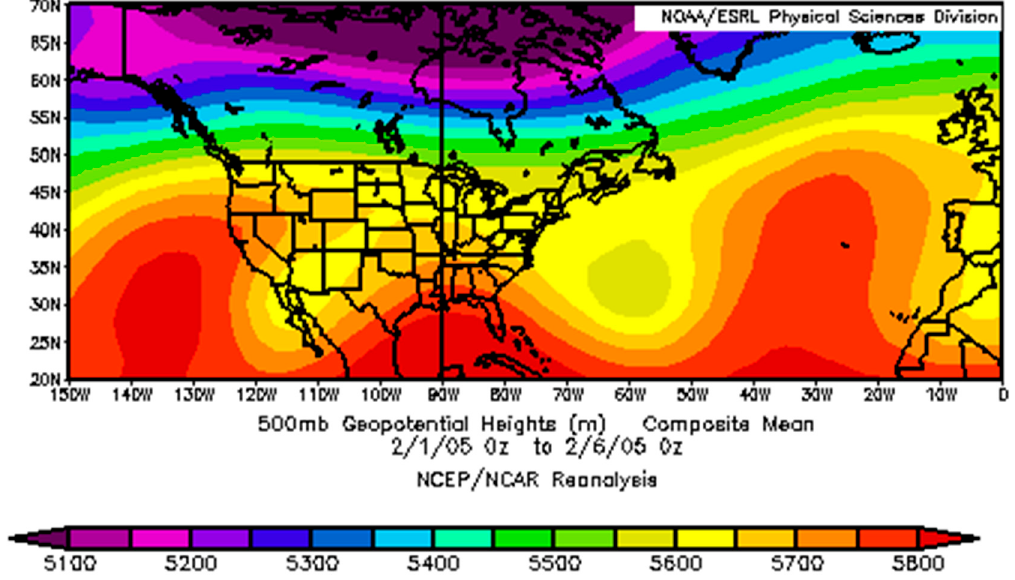
Figure 6. Composite 500 hPa GPH, 1–5 February 2005. Credit: NOAA ESRL PSD (website: http://www.esrl.noaa.gov/psd/).